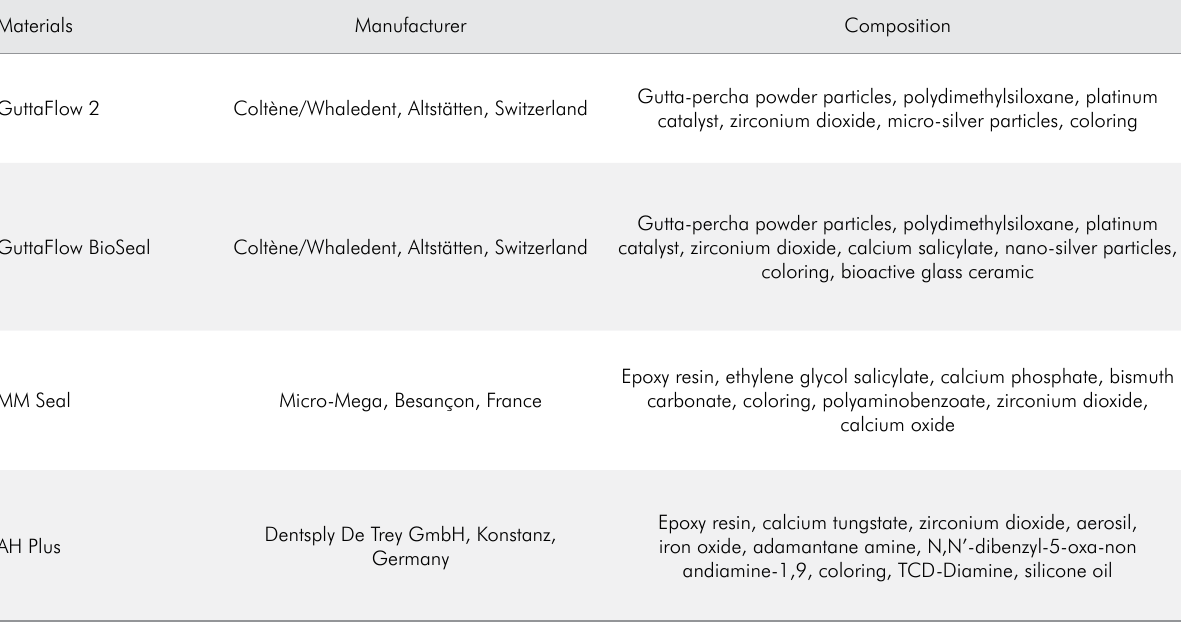
Table 1. Composition of the root canal sealers and their